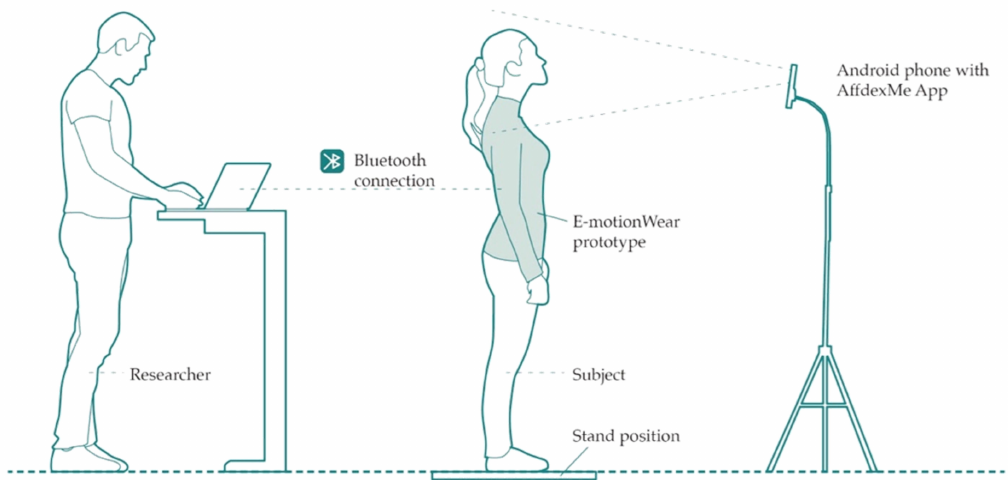
Figure 5. Illustration of the experiment apparatus and set